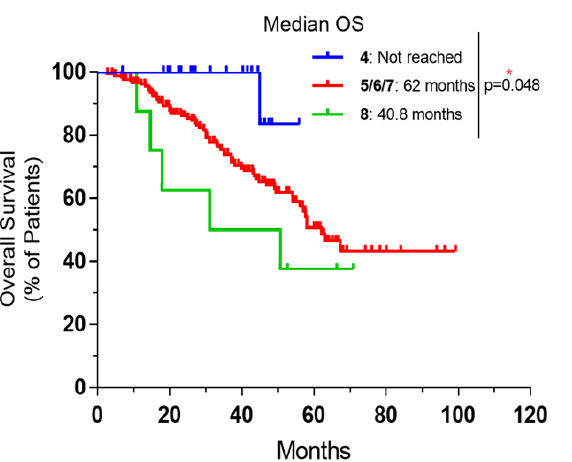
Figure 3. Survival curves of older patients with resectable CRLM according to NLR. ( a ): disease-free survival (DFS) of patients with NLR < 3 compared to patients with NLR ≥ 3. ( b ): overall survival (OS) of patients with NLR < 3 compared to those with NLR ≥ 3. NLR: Neutrophil/Lymphocyte Ratio.